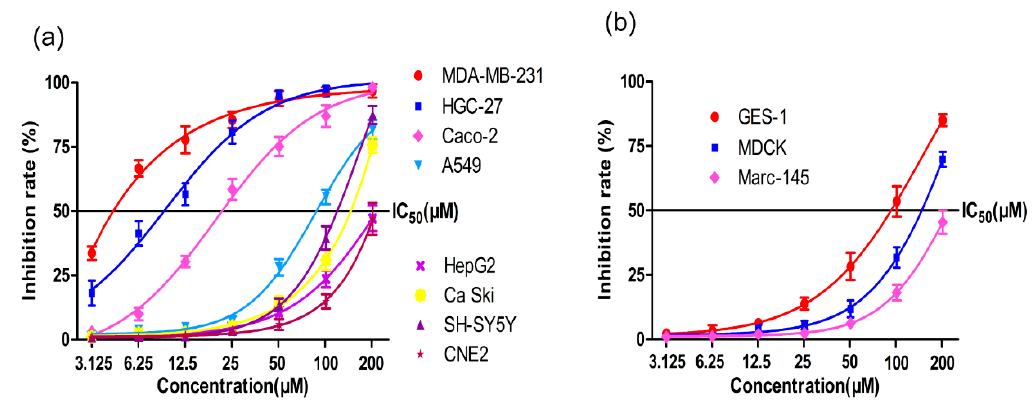
Figure 2. The cytotoxicity of CLE-10 on ( a ) MDA-MB-231, CaCo-2, A549, HepG-2, Caski, SH-SY5Y, HGC-27, CNE-2, ( b ) GES-1, MDCK, and Marc-145 by MTT assay. The data were representative results of three independent tests.